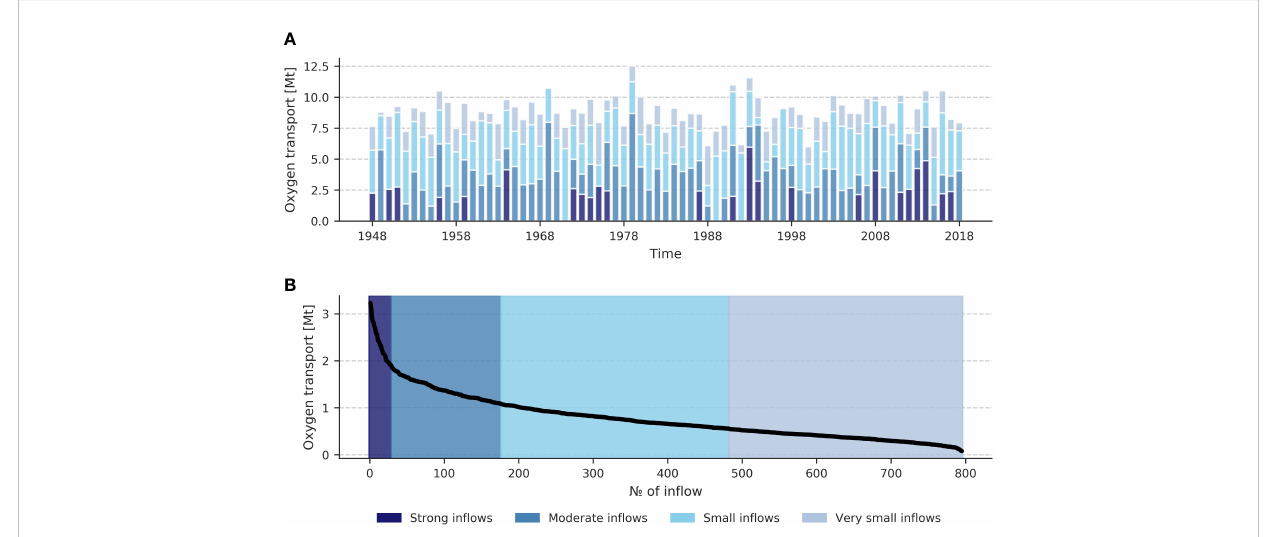
FIGURE 3 Total oxygen transport through the Arkona transect per year by each in fl ow class (A) . Distribution of total oxygen transport per in fl ow sorted in descending order (B) . Colors indicate in fl ow classes. The following classes were de fi ned: strong in fl ows (carry more than 1.8 Mt O 2 ), moderate in fl ows (carry from 1.8 Mt O 2 to 1 Mt O 2 ), small in fl ows (carry from 1 Mt O 2 to 0.5 Mt O 2 ), and very small in fl ows (carry less than 0.5 Mt O 2 ). Mt stands for 10 9